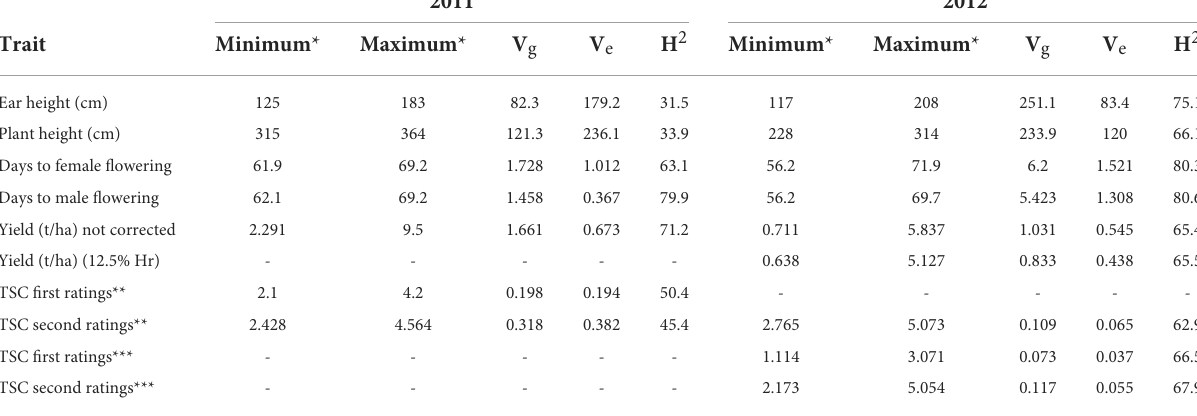
TABLE 1 Summary of the phenotypic data and heritability of TSC (tar spot complex) landrace accession